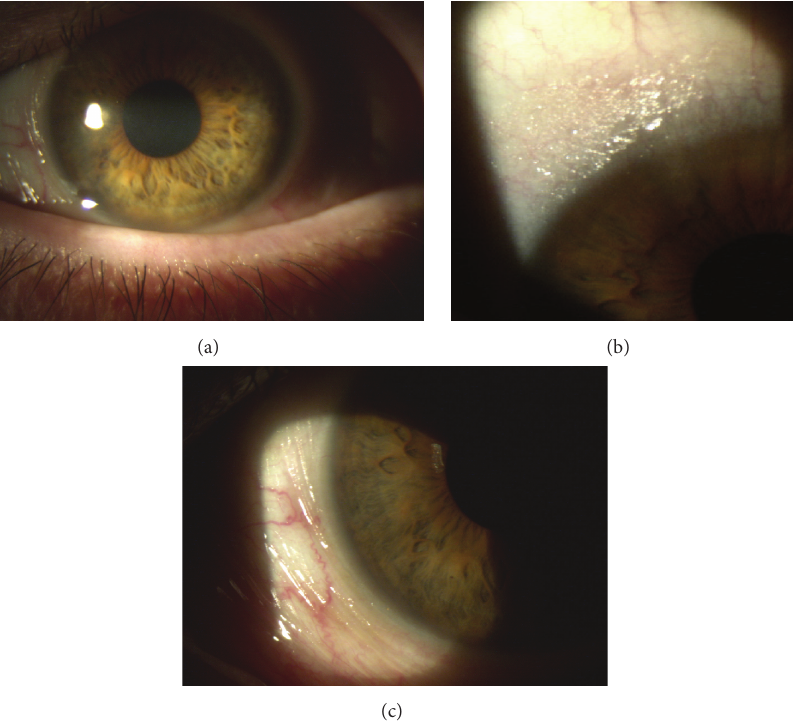
Figure 4: Left eye before